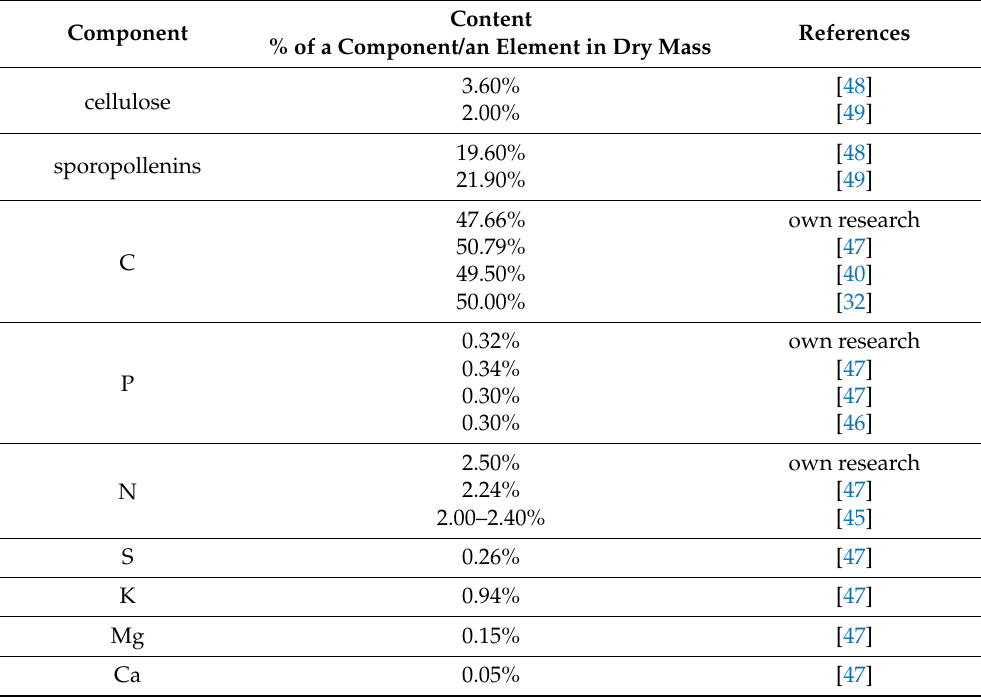
Figure 5. Relative concentration of pollen grains in suspension in surface layer of water measured in May 2018 (the ratio of the number of pollen grains to the total number of suspended particles in size range from 1.25 to 250 µm). Table 2. Selected chemical characteristics of pine pollen grains ( Pinus sylvestris ).